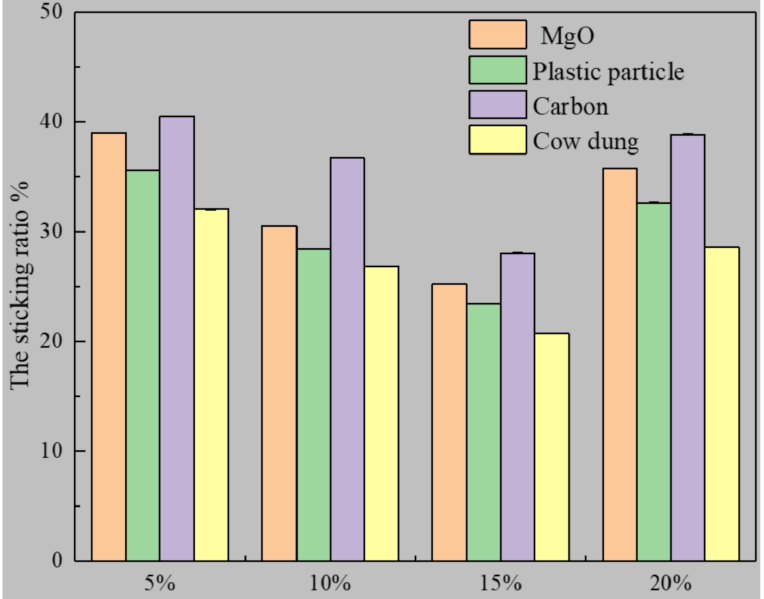
Figure 5. Comparison of sticking ratio of different coating materials and